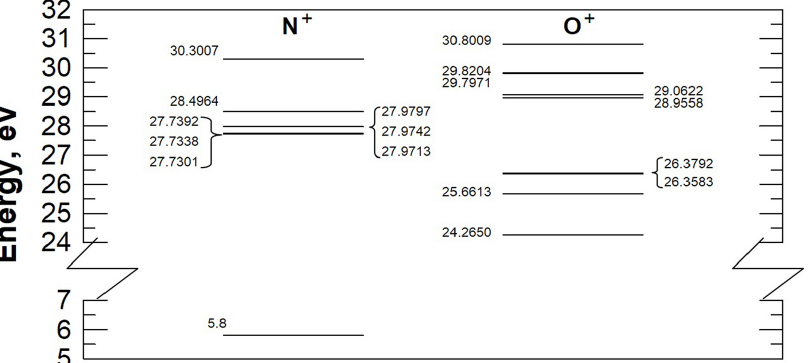
Figure 8. The energy level diagram for the states of O + and N + ions, transitions which are possible from the upper-level state of Table 2.